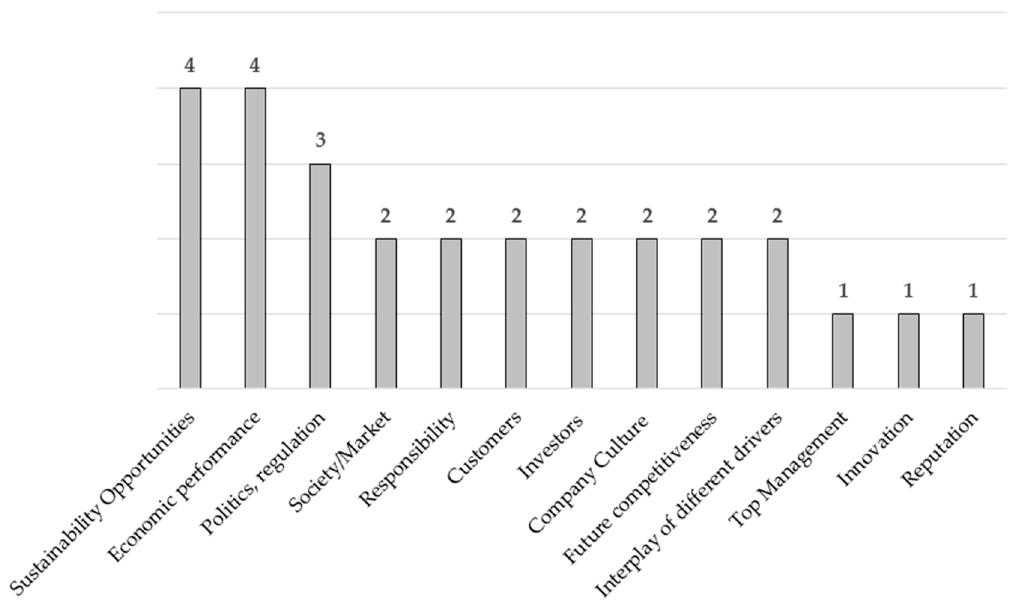
Figure 3. Biggest drivers for sustainability according to interview partners in the chemical industry.